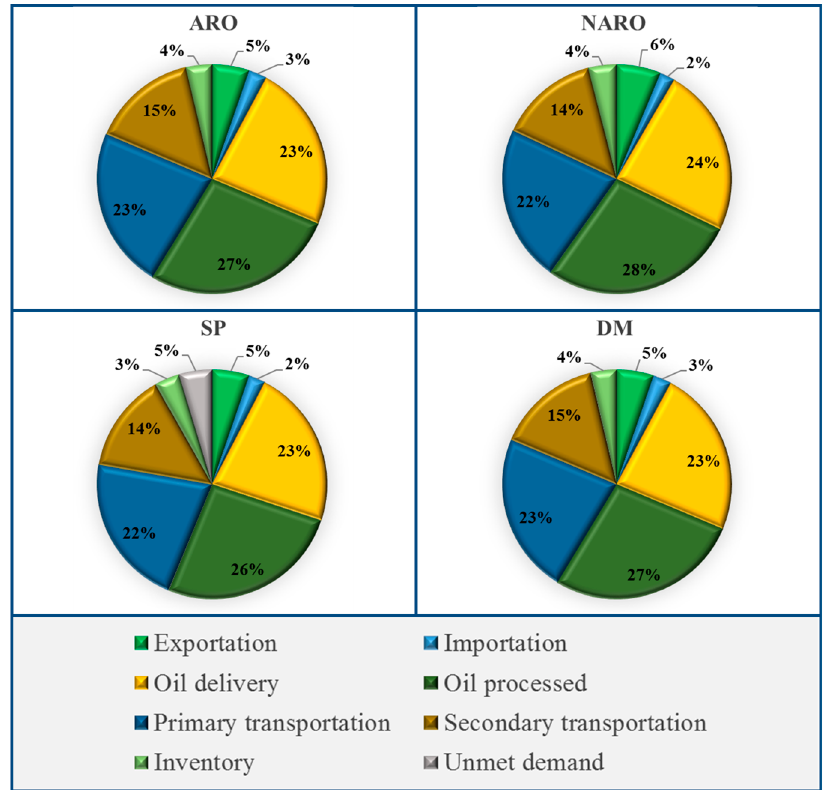
Figure 6. Proportions of the total network volumes among the optimization models.